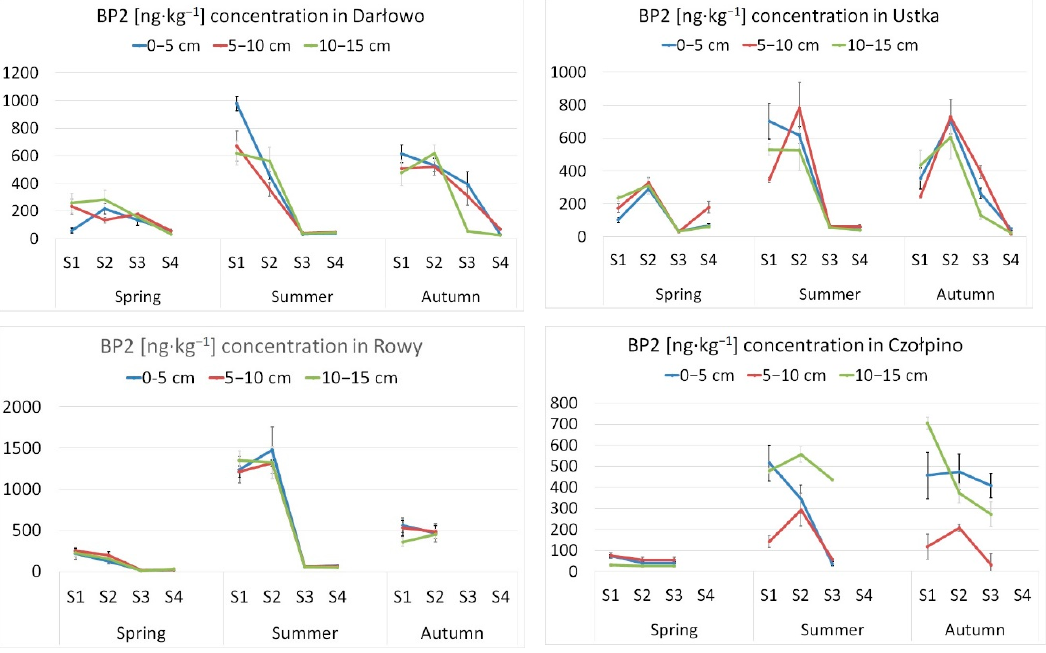
Figure 4. BP-2 [ng · kg − 1 d.w.] concentration in sand sediments collected in Darłowo, Ustka, Rowy, and Figure 4. BP-2 [ng·kg − 1 d.w.] concentration in sand sediments collected in Dar ł owo, Ustka, Rowy, and Czołpino according to depth of the sand core and Czo ł pino according to depth of the sand core and seasonality.